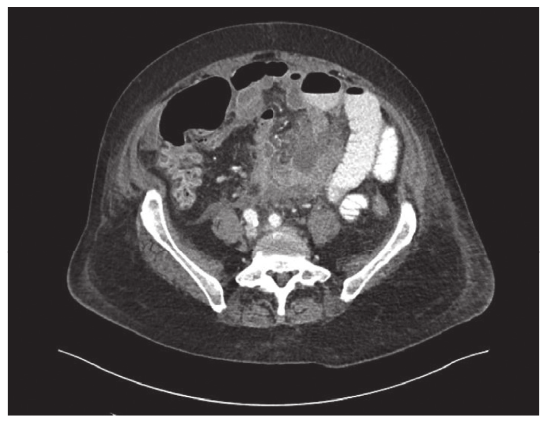
Figure 2: Repeat computed tomography (CT) of the abdomen and pelvis with new peritoneal enhancement suggestive of